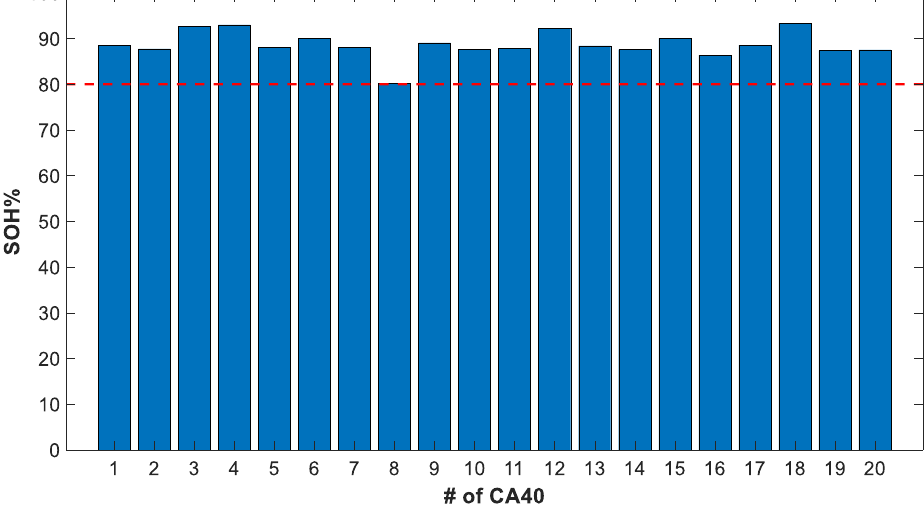
Figure 15. SoH of twenty CALB CA40 cells used in an E-scooter.